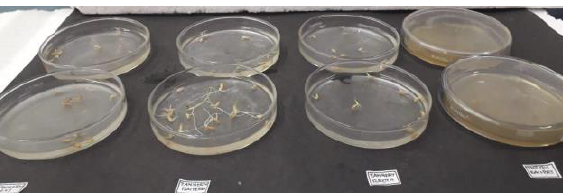
Figure 1. Enterobacter sp.